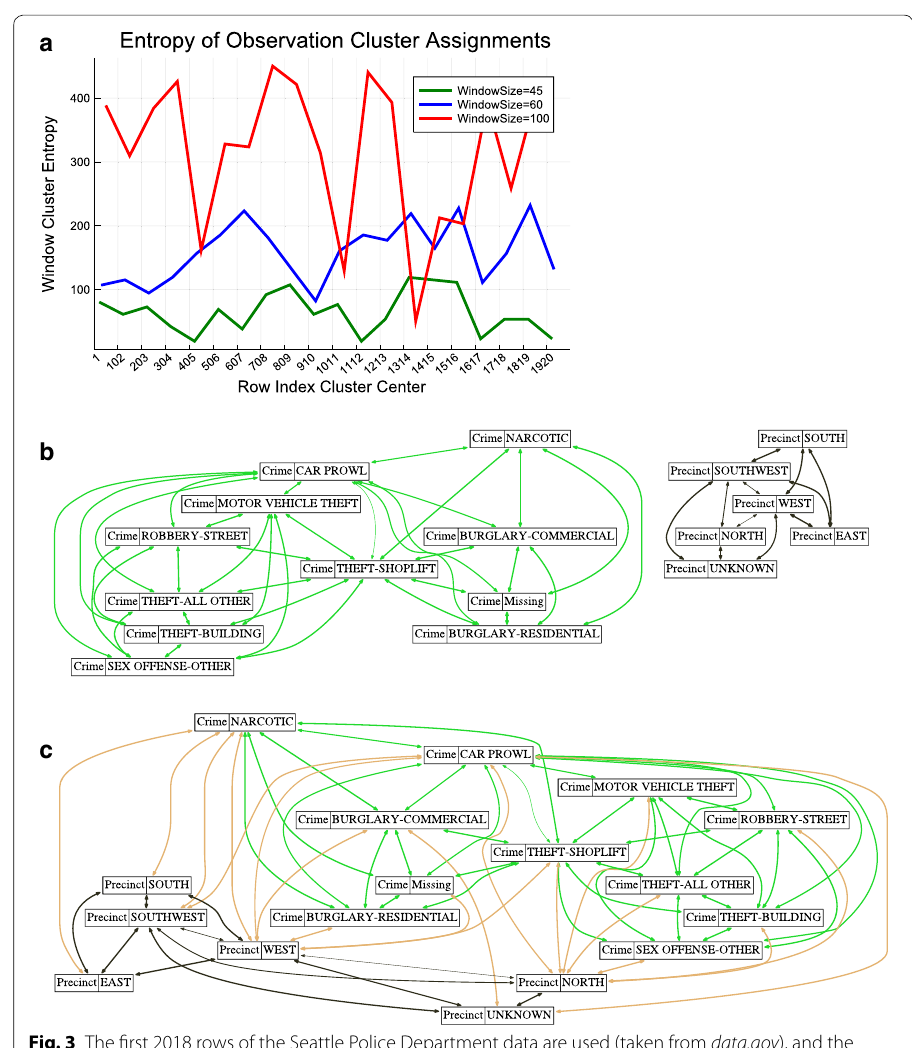
Fig. 3 The first 2018 rows of the Seattle Police Department data are used (taken from data.gov ), and the results can be compared with those of Fig. 2 where the full set of events are used. Subfigure a shows the cluster entropy trace for the window size set. There is greater variability in the trace of the cluster entropy variance estimation for the larger window size of 100 which shows that more data is required to ensure similarities in the subsetting positions and that smaller window sizes have more cross comparisons to reduce the variability. In subfigures b and c it can be seen that crimes ’ARSON’, ’THEFT-BICYCLE’ and ’RAPE’ are not present in the subset data of these events. It can also be seen how the crime ’NARCOTIC’ is recorded in ’Precinct WEST’ where in the previous examination it was